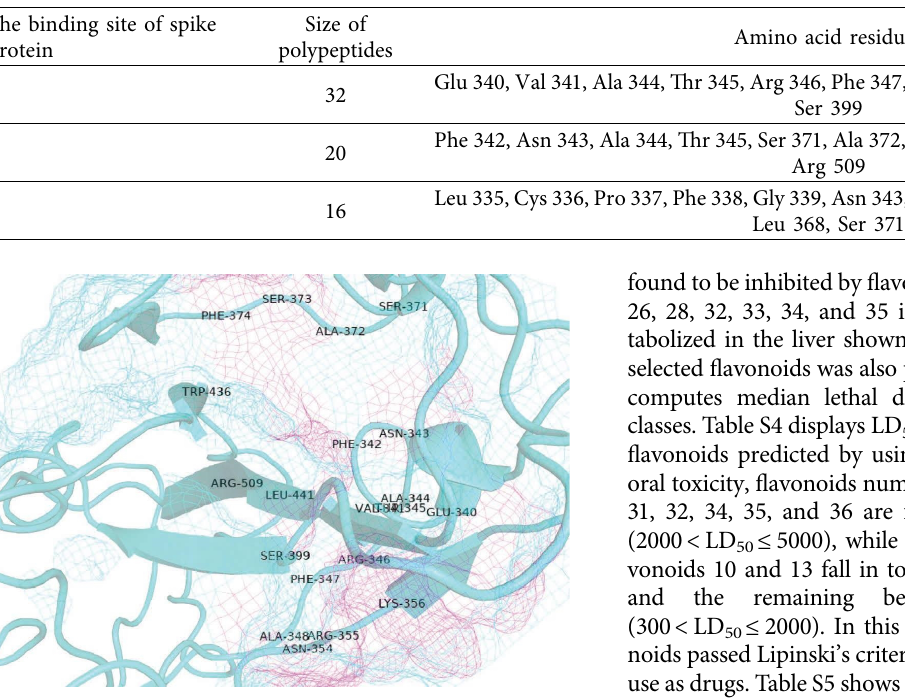
Table 1: Active site residues of spike protein using the Site Finder module.